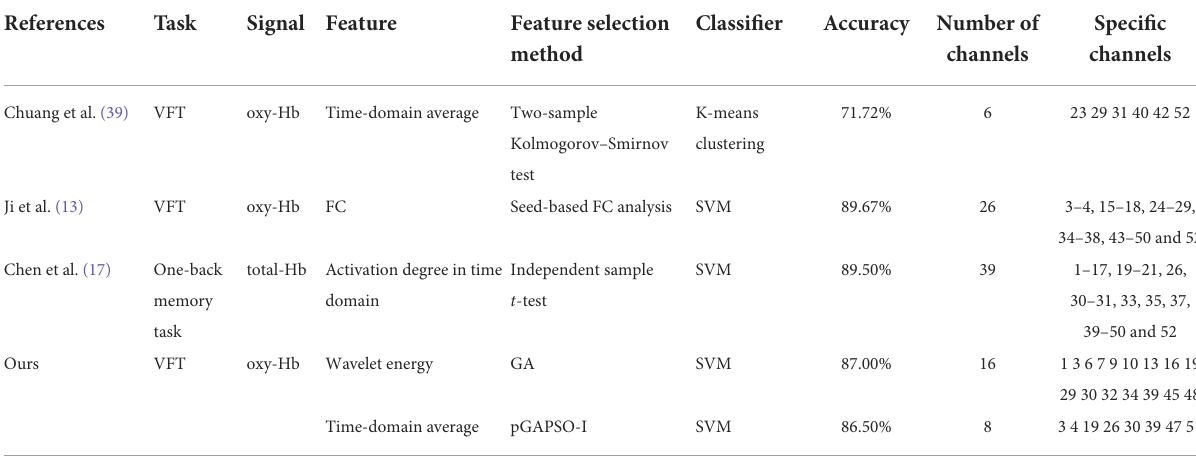
TABLE 5 Comparison between this study and similar 52-channel fNIRS studies aiming at channel reduction in schizophrenic